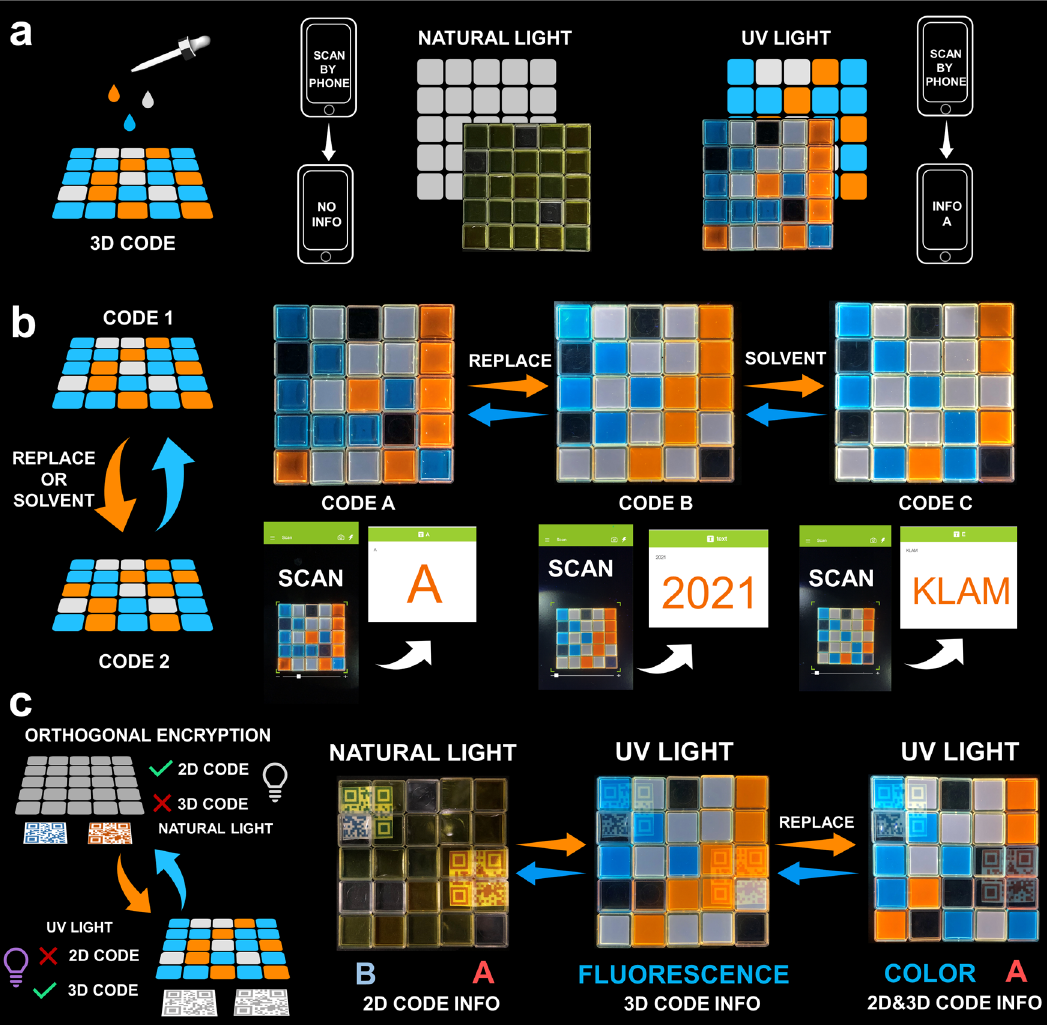
Fig. 5 Dynamic 3D code for information encryption. a Schematic representations of the 3D colour code formation by adding PY16 solution dropwise to quartz containers. Blue, white and orange represent the DMSO, DMSO/H 2 O, and H 2 O solutions, respectively. The daylight and fl uorescence images of the 3D code are included. The encoded information could be recognized under UV light but could not be identi fi ed under natural light. b Schematic representations for the 3D code transformation by means of physical action or introducing solvent. Photographs of the 3D codes under UV light are presented, and the corresponding information was read using a smartphone. c A visual scheme illustrating the information orthogonal encryption process and photographs of new codes combining 2D code and 3D